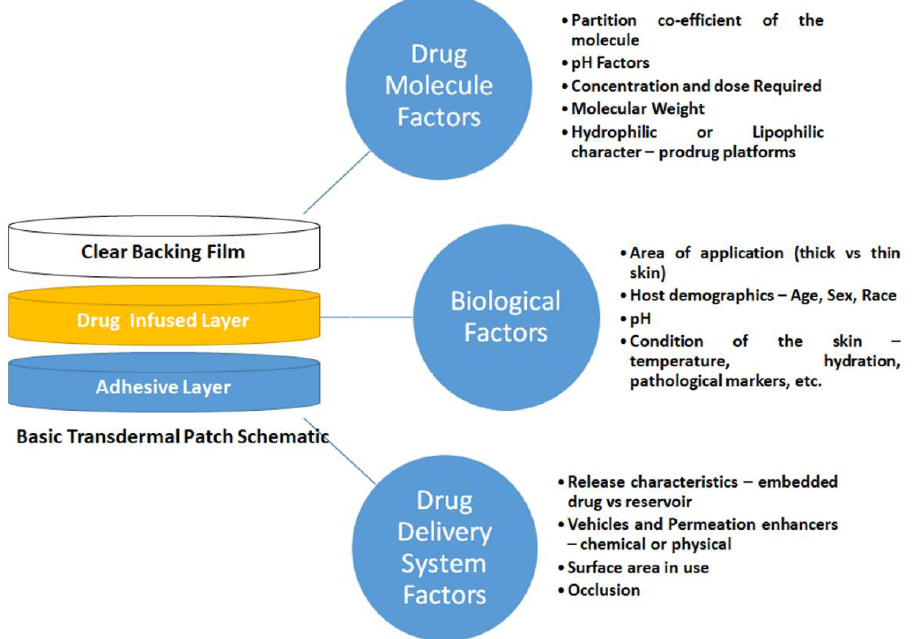
Figure 4. Depiction of the most critical factors to consider when designing a transdermal drug delivery system.